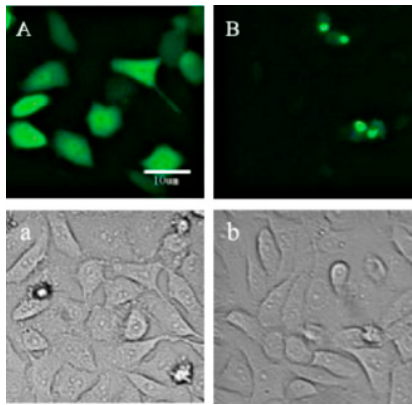
Figure 1. Expression of fluorescence proteins of Venus and p21 -Venus after transfection in HeLa cells. ( A , a ): HeLa cells transfected with Venus; ( B , b ): HeLa cells transfected with p21 -Venus. Scale bar = 10 μ m.